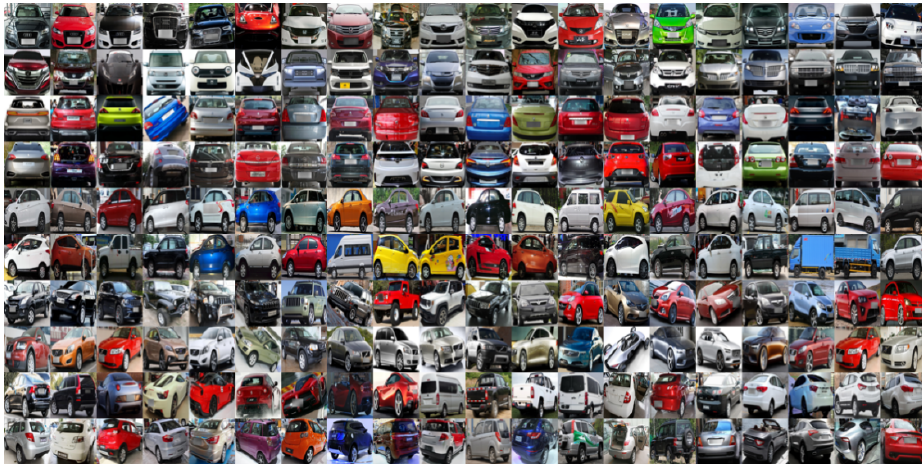
Figure 9. Sample images from the CompCars dataset.